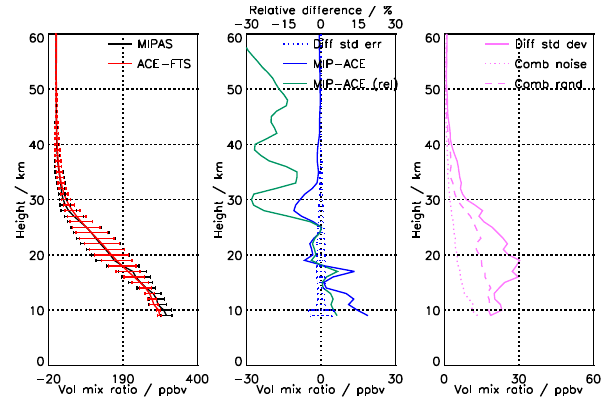
Figure 11. Comparison of CH 4 from SCIAMACHY and MIPAS full resolution (V5H_CH4_21). Details as in Fig. 1.